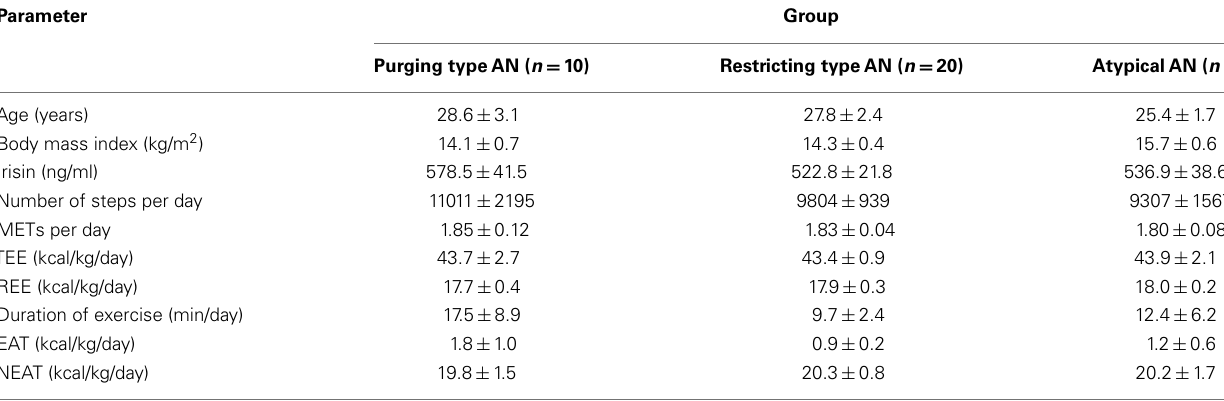
Table 1 | Parameters of energy expenditure according to the subtype of anorexia nervosa . Parameter